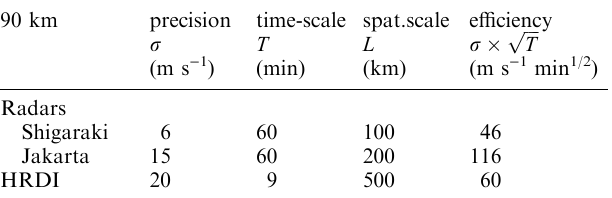
Table 4. Estimated precision of HRDI and meteor-radar wind velocities at 90-km altitude. For comparative purposes, the e(cid:129)ciency of the observation technique defined by the multiple of the precision and square root of the representative time-scale is also shown; see text for details 90 km precision time-scale spat.scale e(cid:129)ciency (cid:114)